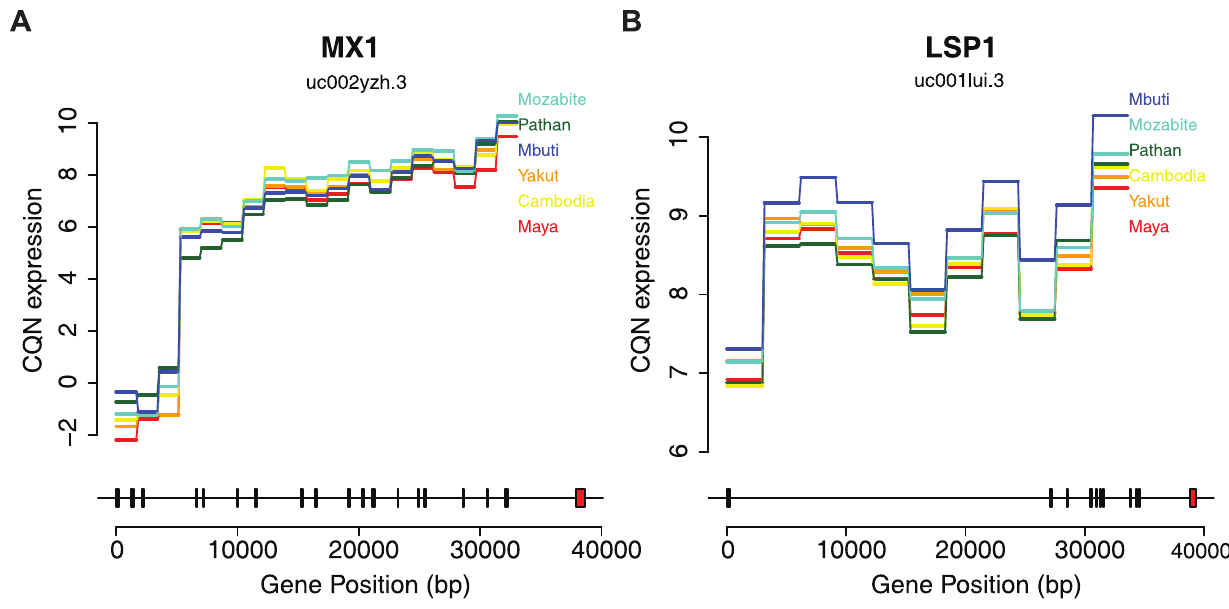
Figure 3. Differential expression across human populations. Bottom plots show exon positions indicated by rectangles to physical position scale. Red rectangles are differentially expressed exons. Upper plots show the median conditionally quantile normalized (CQN) expression values per population of each exon in horizontal lines. Diagonal lines connect each exon. Each exon corresponds one-to-one with the transcript structure shown below but have been scaled evenly to the width of the plot for ease of visualization. Population orders on the right correspond with the order of expression values of the last exon. A) Expression by population of the uc002yzh.3 transcript of MX1. B) Expression by population of the uc001lui.3 transcript of